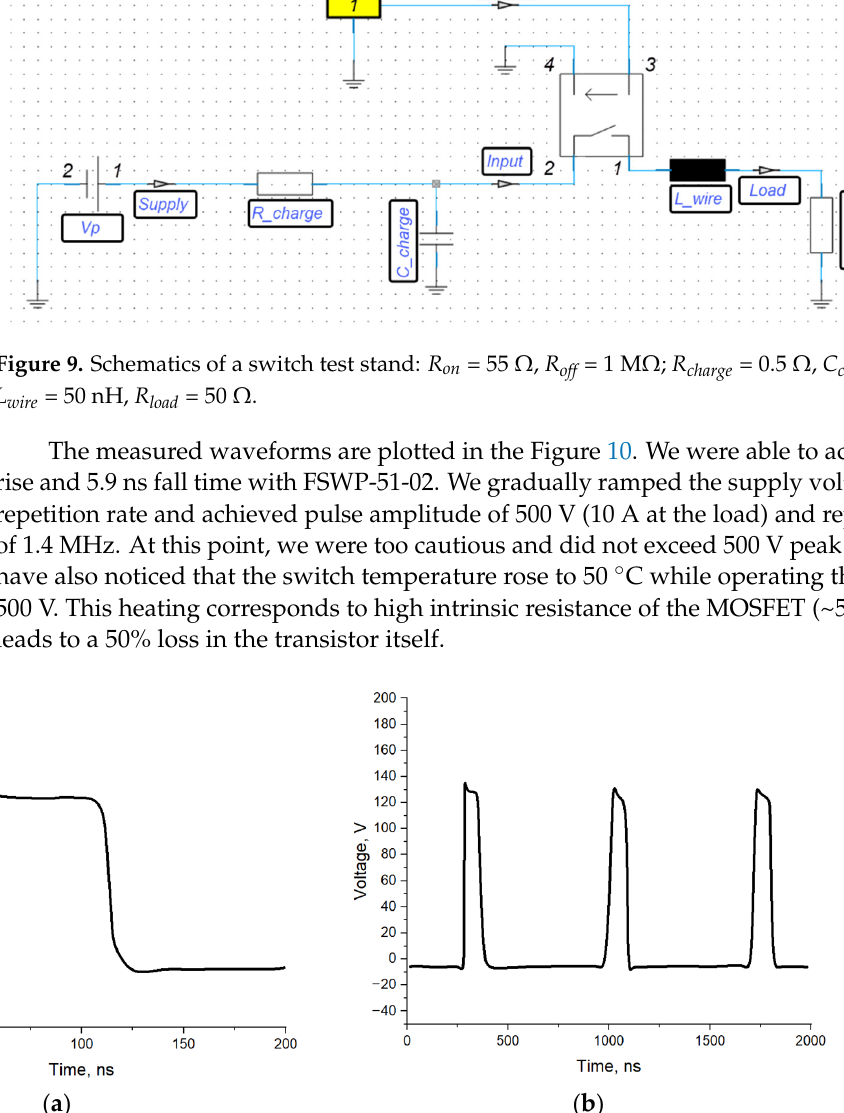
Figure 8. High-power test stand for high-voltage (HV) switch ( a ) and a close-up photo of the stripline ( b ).